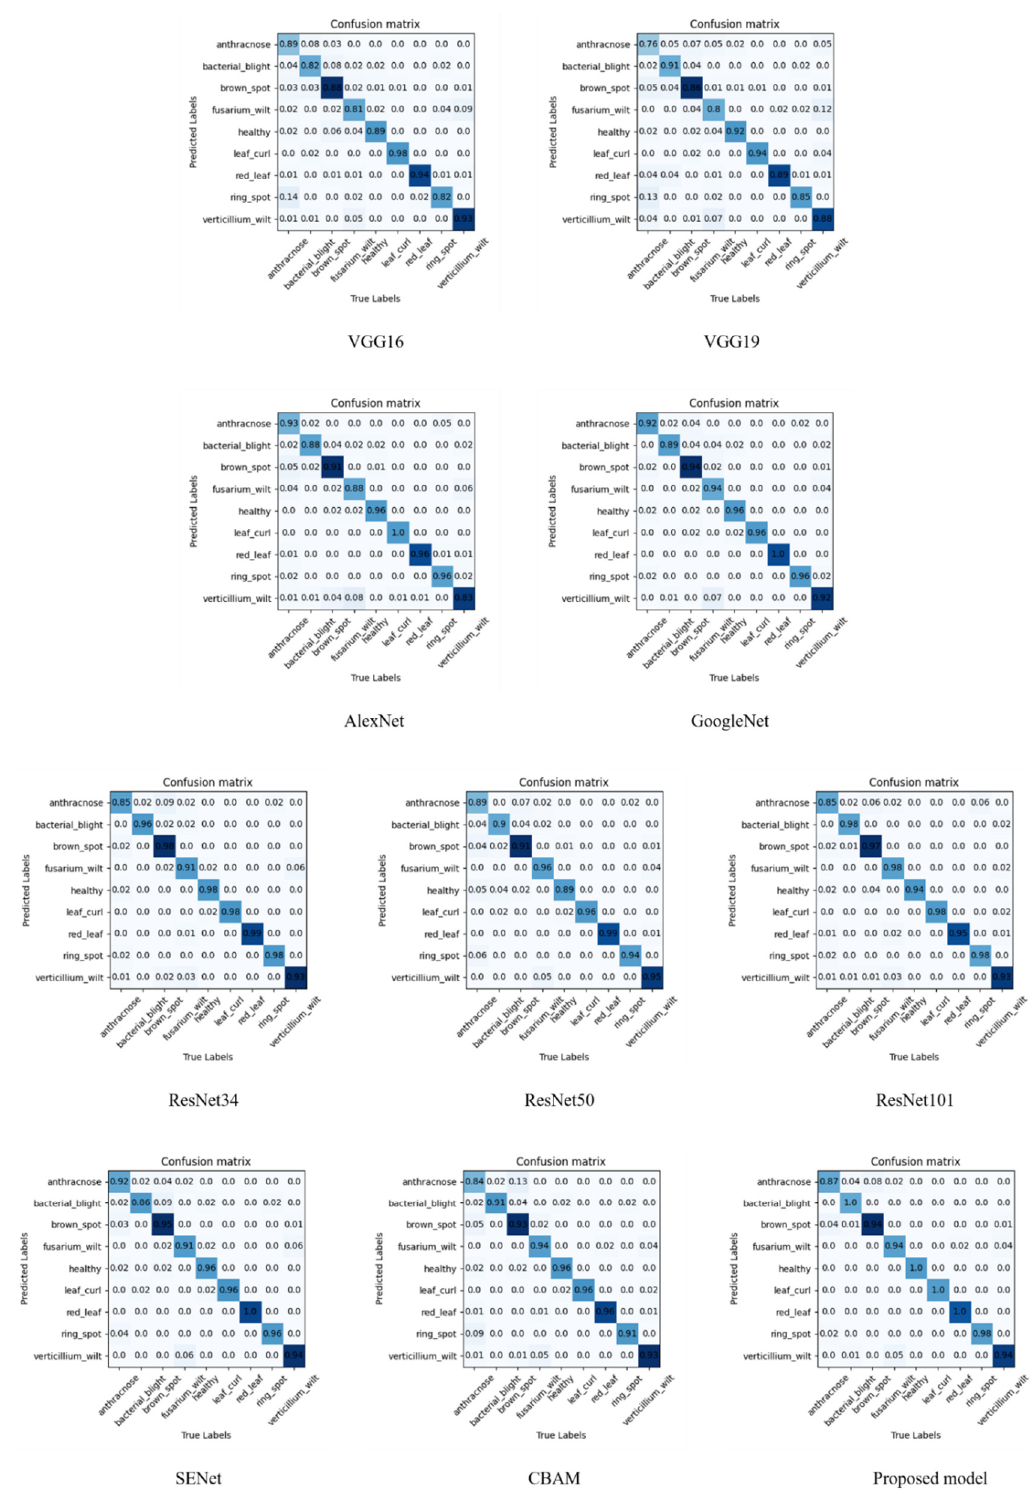
Figure 9. Confusion matrix. Where each row represents the true label of each type, each column is the predicted label of the model, the median value is the probability that the row type is predicted to be a column type, and the diagonal value is the probability of correct classification.